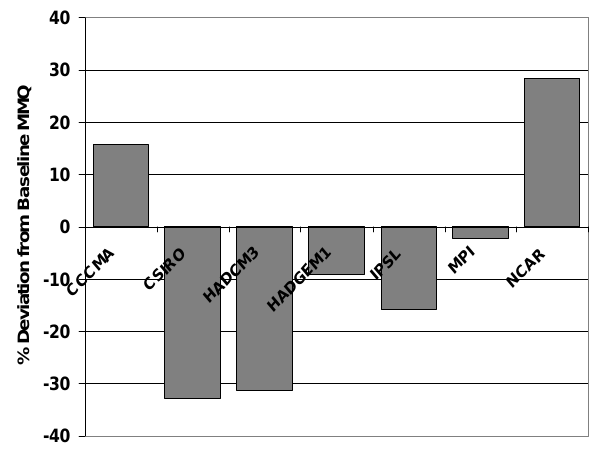
Fig. 8. Mean calendar monthly flow for the Okavango River at Figure 8 Mean calendar monthly flow for the Okavango River at Mukwe based 871 Mukwe based on a 1000 member ensemble simulation for the 7 on a 1000 member ensemble simulation for the 7 GCMs, compared to 872 GCMs, compared to the baseline simulation. the baseline simulation. 873